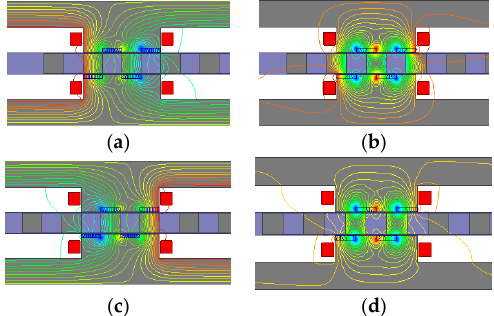
Figure 8. The distribution of magnetic flux lines: ( a ) The 0 electrical degrees position; ( b ) The 90 electrical degrees position; ( c ) The 180 electrical degrees position; and, ( d ) The 270 electrical degrees position.